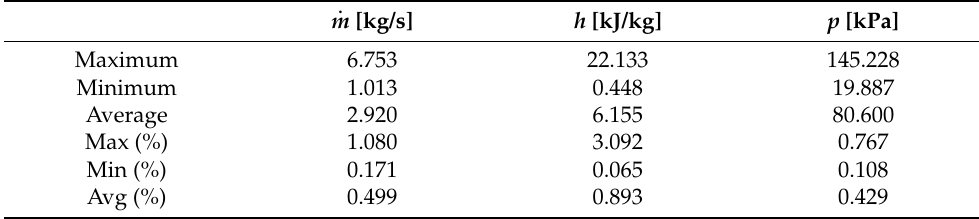
Table 9. Performance (absolute and relative errors) per output parameter for the PINN model of the recuperated Brayton cycle that used the hybrid Adam-TNC